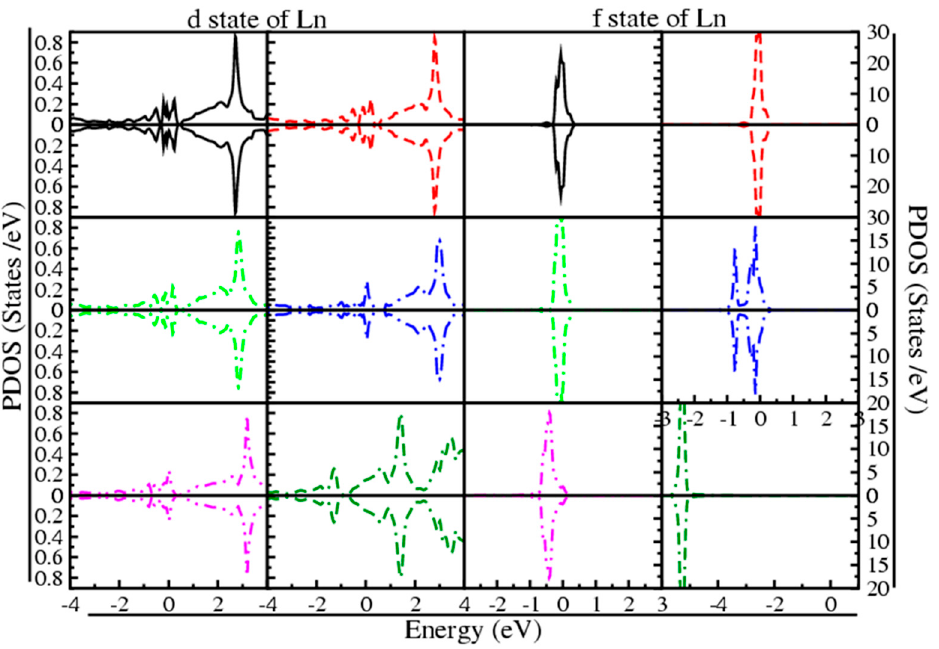
Figure 8. Partial DOS of the rare earth nitrides Ln 3 NIn (Ln = Dy-Lu) anti-Perovskite. Black, red, green, blue, magneta and dark green colors indicate the d and f state for Dy 3 NIn, Ho 3 NIn, Er 3 NIn, Tm 3 NIn, Yb 3 NIn and Lu 3 NIn.